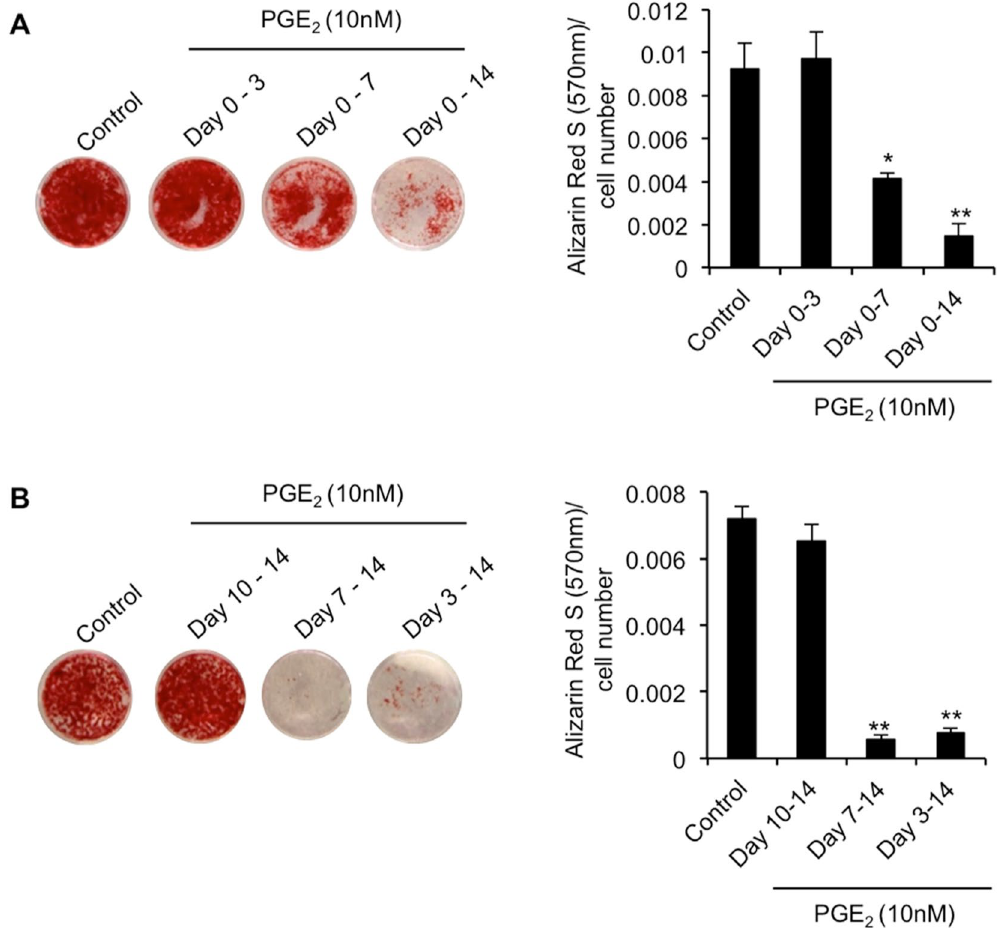
Figure 2. Effect of PGE 2 on hBMSC-mediated matrix mineralization is dependent on differentiation stage of hBMSC osteogenesis and duration of exposure. hBMSCs were treated with PGE 2 (10 nM) for varying durations beginning at the initiation of osteogenic induction (Day 0) ( A ), or at selected time points thereafter ( B ), and matrix mineralization quantified at day 16 by Alizarin Red S staining. * p < 0.01, ** p < 0.001 as compared to hBMSCs induced to undergo osteogenesis for 14 days in the absence of PGE 2 (control) using ANOVA. The data represent triplicate determinations and were replicated at least two times. All values are presented as mean ±